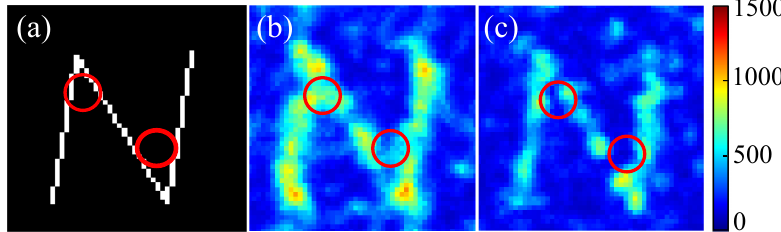
Figure 9. Neighboring intensity minimization using SBGA. ( a ) The target pattern, ‘ N ’. ( b ) Optimal speckle image without minimizing neighboring intensity ( f 1 , f 2 ). ( c ) Optimal speckle image with the third discriminant to minimize neighboring intensity ( f 1 , f 2 , f 3 ). The main differences are marked by the red